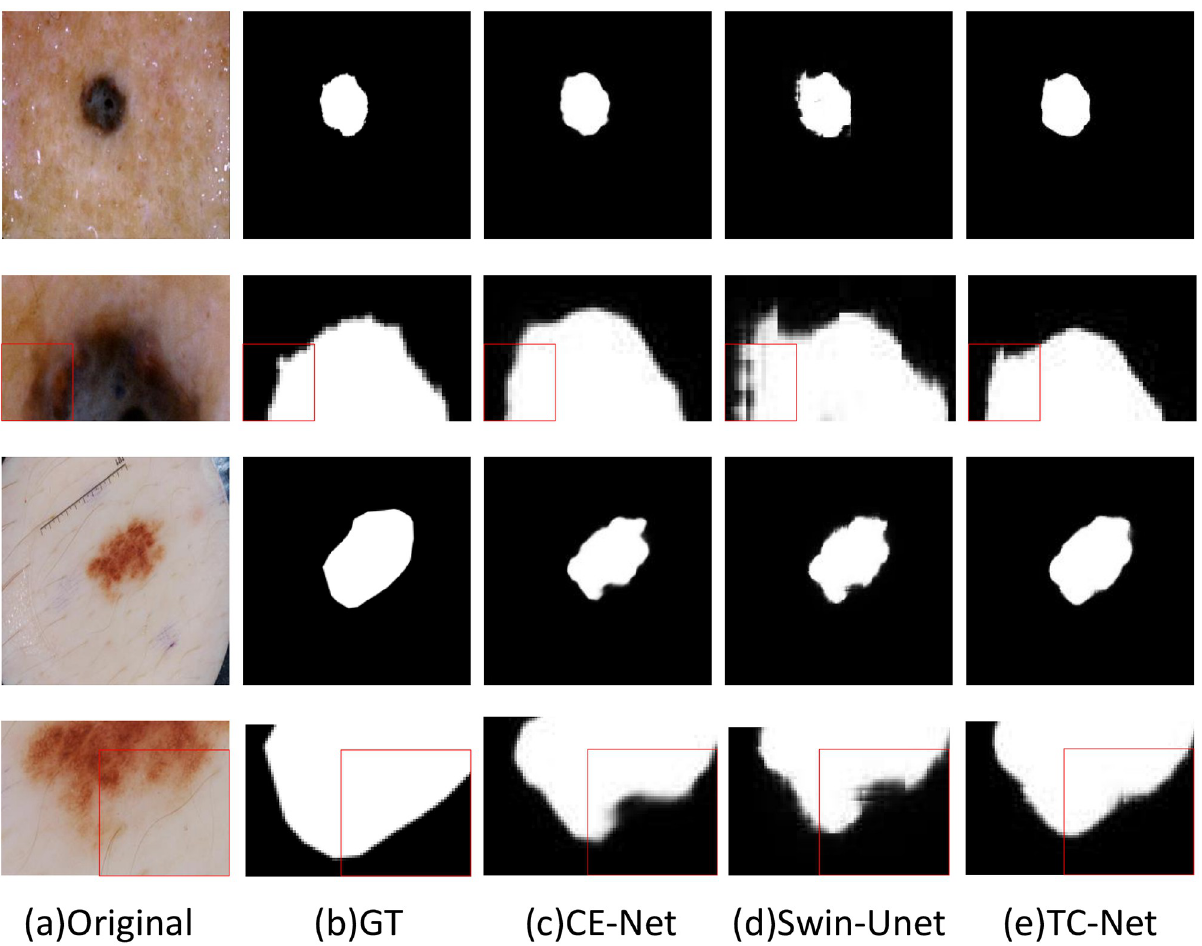
Fig 8. The detail analysis on ISBI2017 dataset, (a) original image; (b) GT label image; (c) Segmentation image of CE-Net; (d) Segmentation image of Swin-UNet; (e) Segmentation image of TC-Net.The red box indicates the segmentation edge information at the same